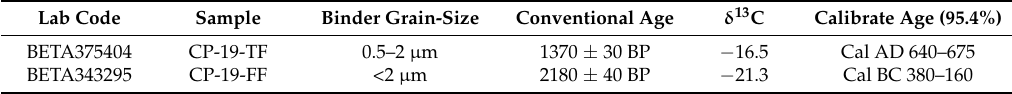
Table 4. Results of AMS 14 C dates for different grain-size fractions of mortar